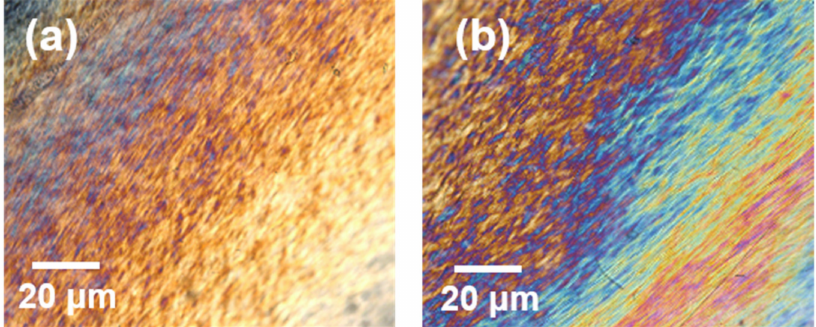
Figure 3. POM observations of the pure CNC film: ( a ) the center region and ( b ) the edge region.